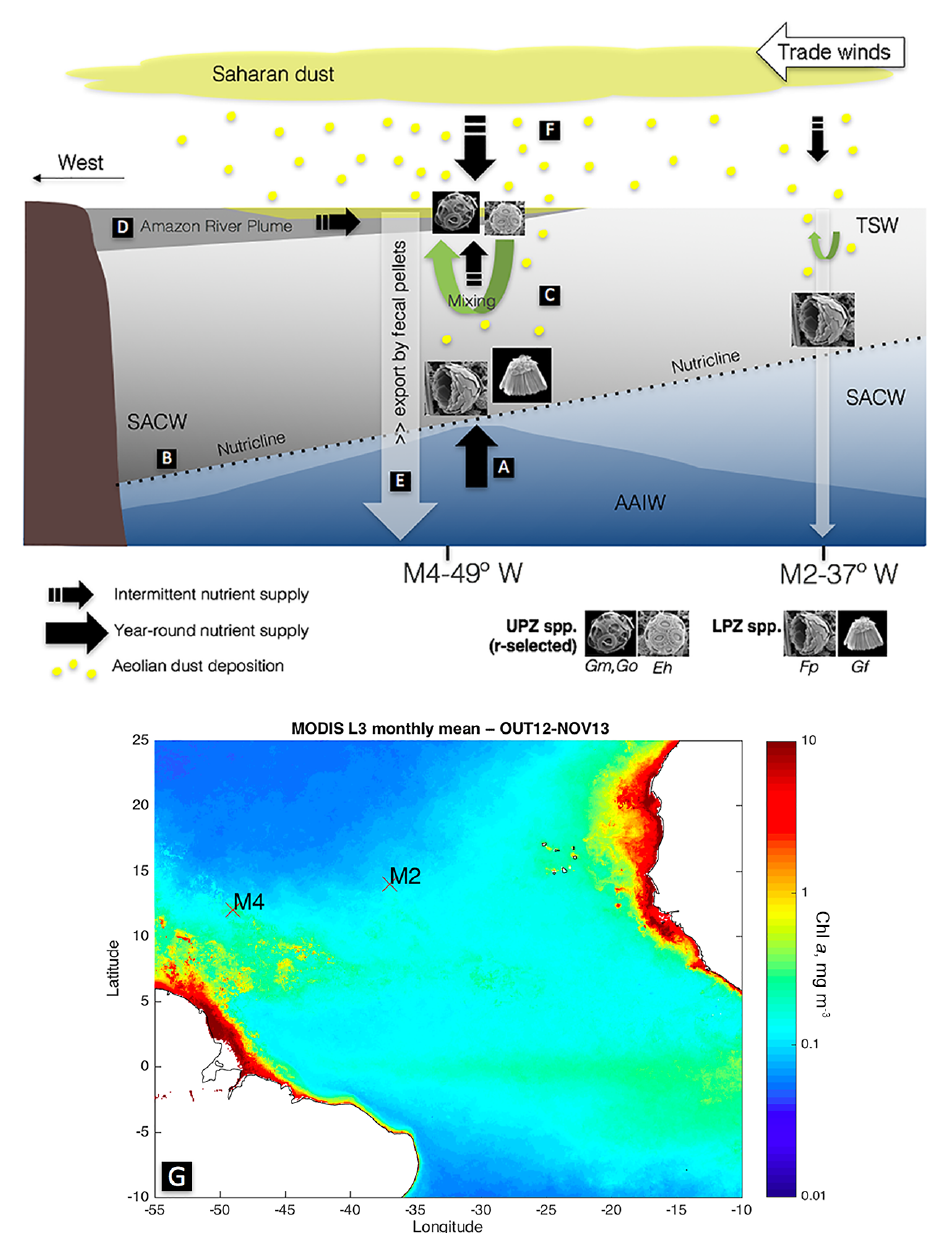
Figure 10. Schematic figure summarizing the main environmental mechanisms interpreted as being at the origin of the ecological contrasts observed between stations M4 and M2 from October 2012 to October–November 2013: (A) nutrient supply by AAIW depth range oscillations (dark blue lowermost layer) combined with (B) nutricline E–W basin-scale tilting (dashed black line), promoting the development of the LPZ species G. flabellatus and F. profunda further west; (C) wind-forced surface ocean mixing and (D) eastward dispersion of the Amazon River Plume, resulting in transient “pulse-like” increases in the opportunistic UPZ species E. huxleyi , G. muellerae , and G. oceanica ; (E) higher production of faecal pellets by zooplankton grazers (white vertical arrow) at M4 contributing to increase the coccolith export efficiency; (F) Saharan dust deposition (yellow dots) influencing the study area, particularly at M4 where the Amazon River Plume acts as a surface density retainer of nutrients settling from the atmosphere; (G) sea surface Chl a concentrations averaged for the sampling period in the equatorial Atlantic Ocean illustrating the contrast between higher and lower surface productivity at stations M4 and M2, respectively. Abbreviations: UPZ – upper photic zone; LPZ – lower photic zone; E. huxleyi – Eh; G. muellerae – Gm; G. oceanica – Go; Fp – F. profunda ; Gf – G. flabellatus ; TSW – tropical surface water; SACW – South Atlantic Central Water; AAIW – Antarctic Intermediate